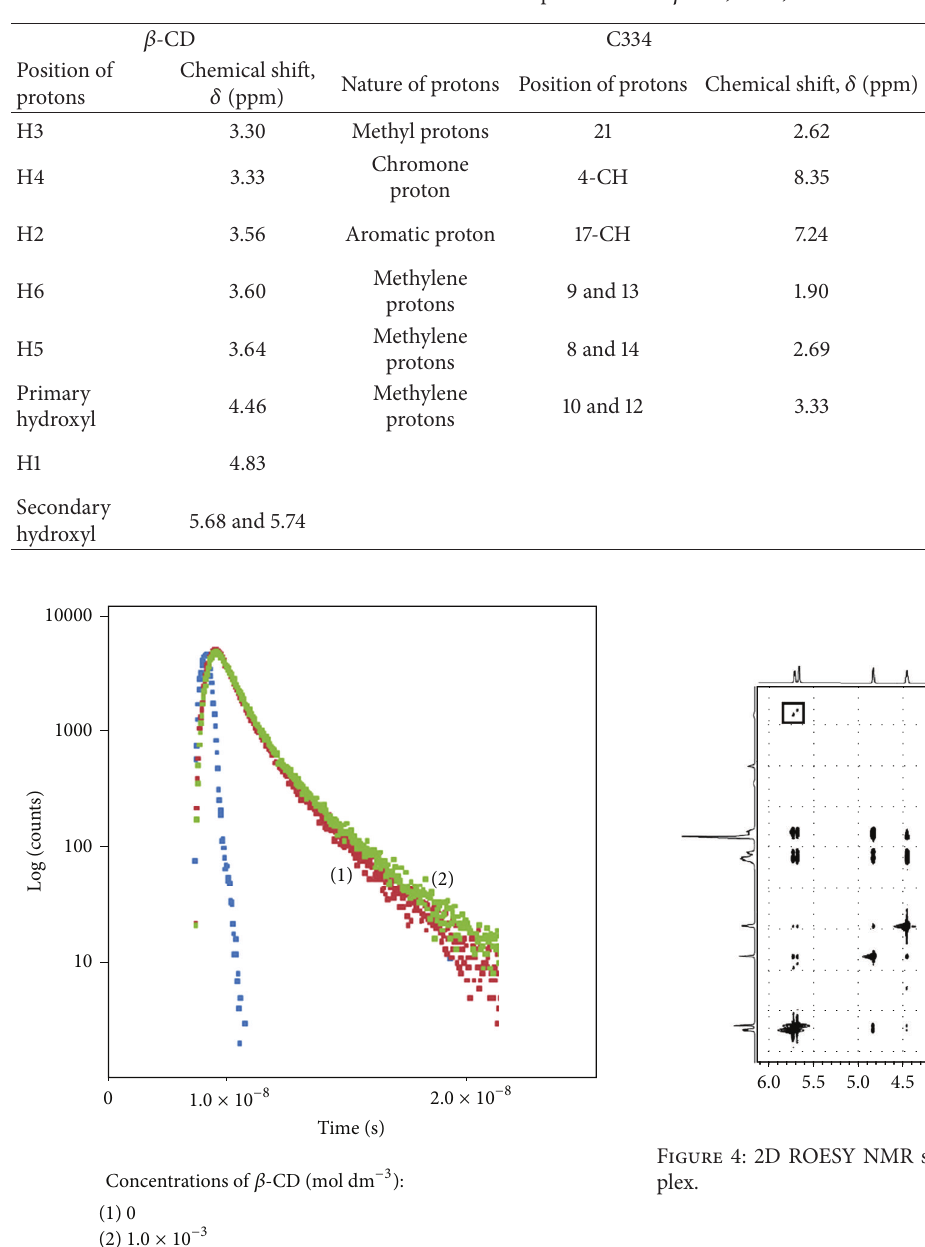
Table 3: 1 H NMR spectral data of 𝛽 -CD, C334, and C-HPA.